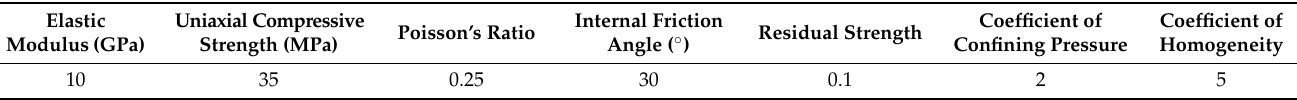
Table 1. Mechanical parameters of the rock mass.